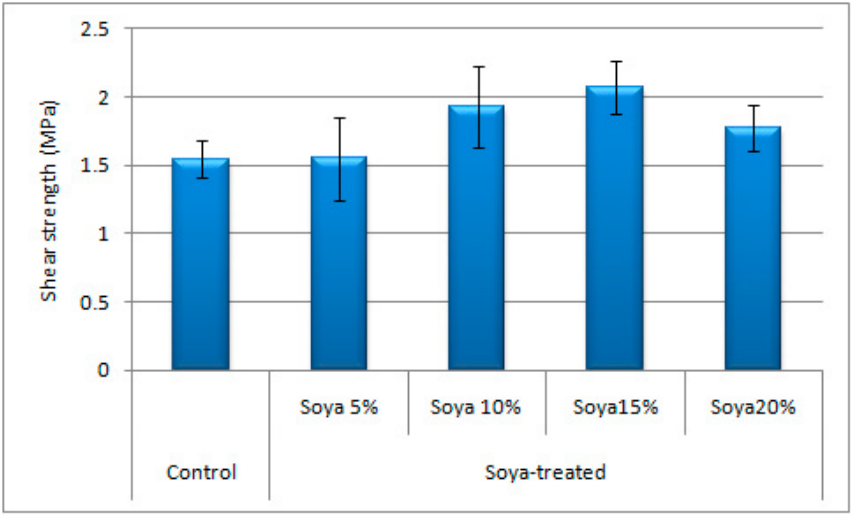
Figure 4. Formaldehyde emission (mg/kg) in three-layer plywood panels produced with urea- formaldehyde resin and 5%, 10%, 15%, and 20% soy flour substitution of UF resin.